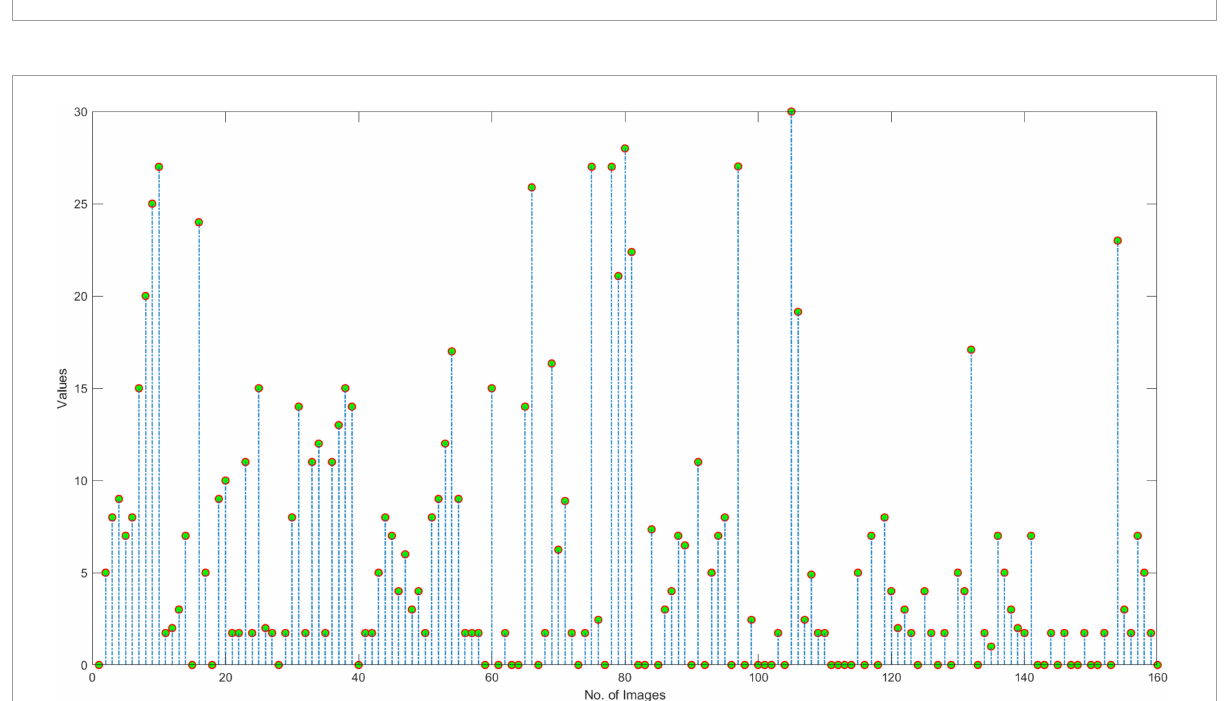
FIGURE13 Similarity with MI